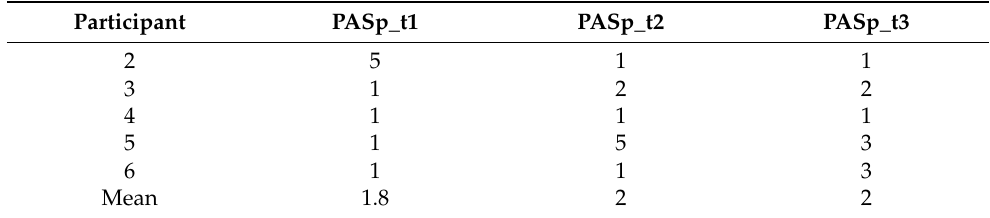
Table 27. PAS (worst), pudding 10 mL (points) individual and mean measurements at three assess- ment time points.